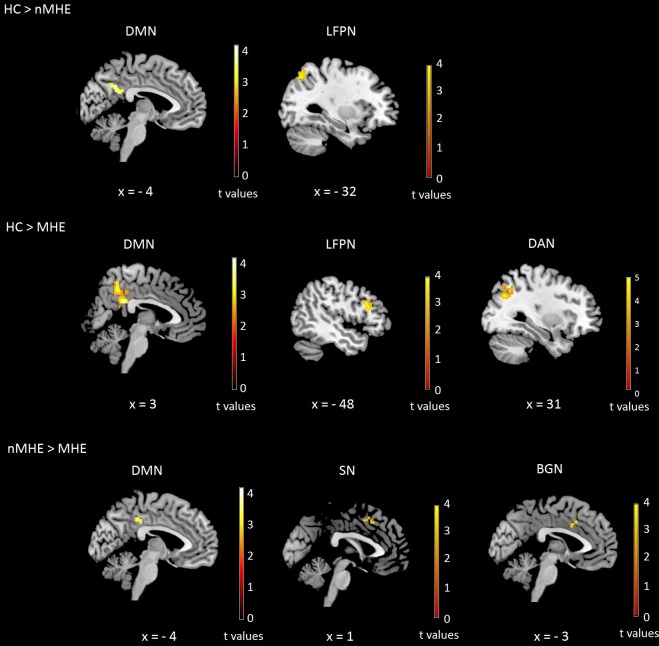
Differences among groups in the resting-state functional connectivity (rs-FC) networks including gender as a nuisance variable.All results were assessed at p<0.05 FWE cluster-corrected for the multiple comparisons in a combination with a threshold of p<0.001 at the uncorrected voxel level. HC, Healthy Controls; nMHE, patients without Minimal Hepatic Encephalopathy; MHE, patients with Minimal Hepatic Encephalopathy; DMN, Default Mode Network; LFPN, Left Fronto Parietal Network; DAN, Dorsal Attentional Network; SN, Salience Network; BGN, Basal Ganglia Network. Images are in neurological convention.